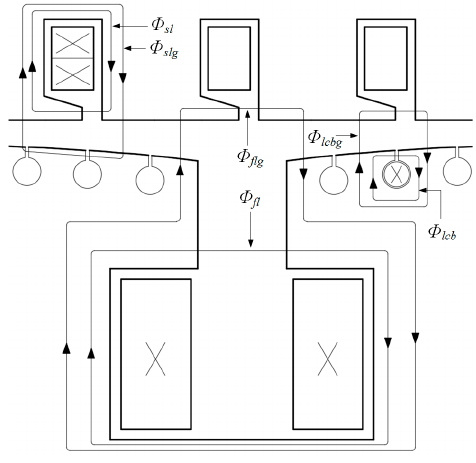
Figure 2. Schematic of SPSM leakage flux paths.